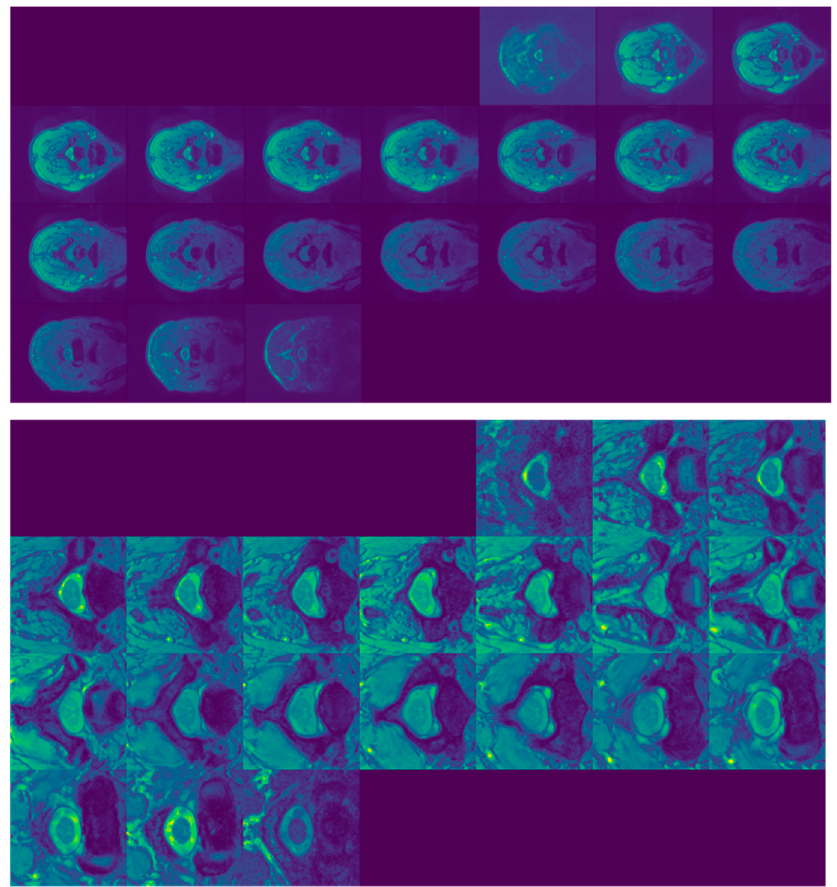
Figure 5. Slices of SCGM MRIs of subject 10 from site 3. Original image size is 654 × 774. A dark square indicates that the slice does not contain any gray or white matter. Original slices are displayed in the top row while cropped ones are exhibited in the bottom one.